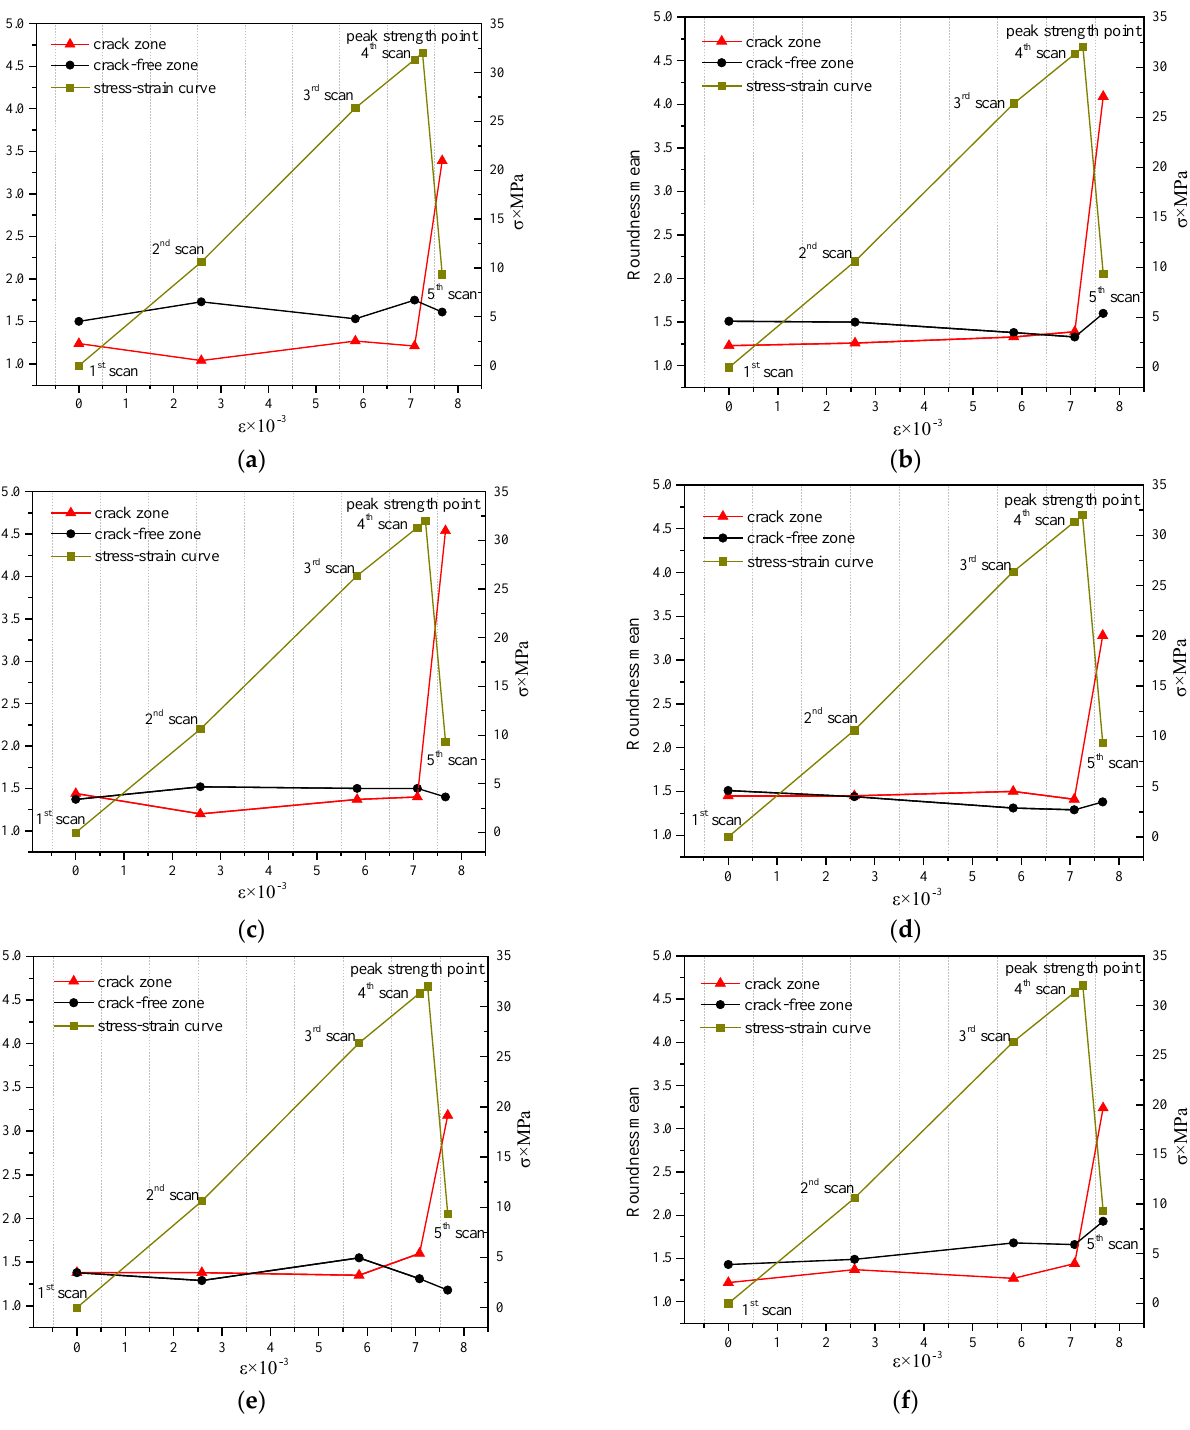
Figure 10. Variation of roundness mean at the two areas with loading, ( a ) S120, ( b ) S130, ( c ) S140, ( d ) S150, ( e ) S160, ( f ) S170.